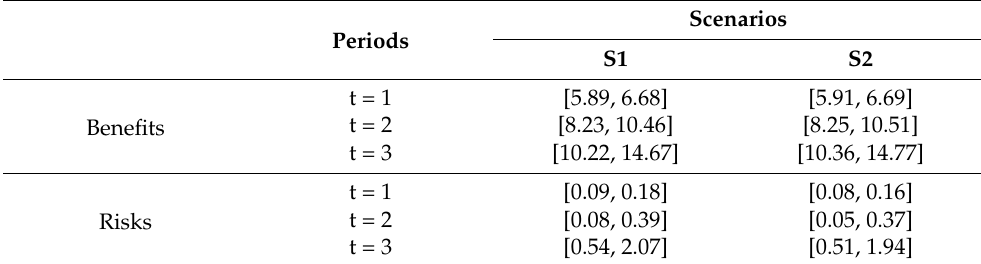
Table 5. Benefits of water resource utilization and risks in the Fenhe River Basin (10 6 million).